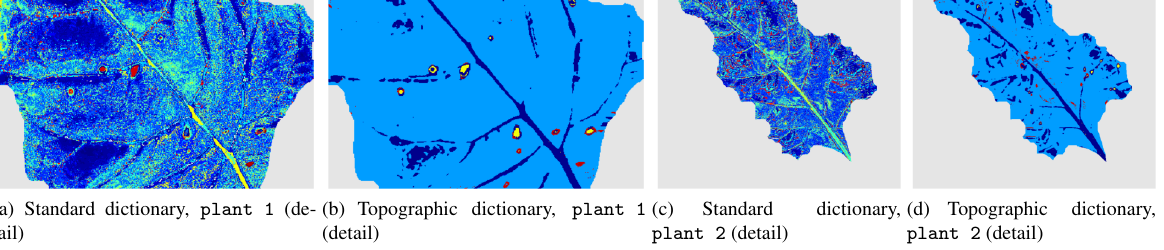
Figure 6: Color coded indices of dominant dictionary elements for sparse representation with topographic and standard dictionary (i.e. , no group